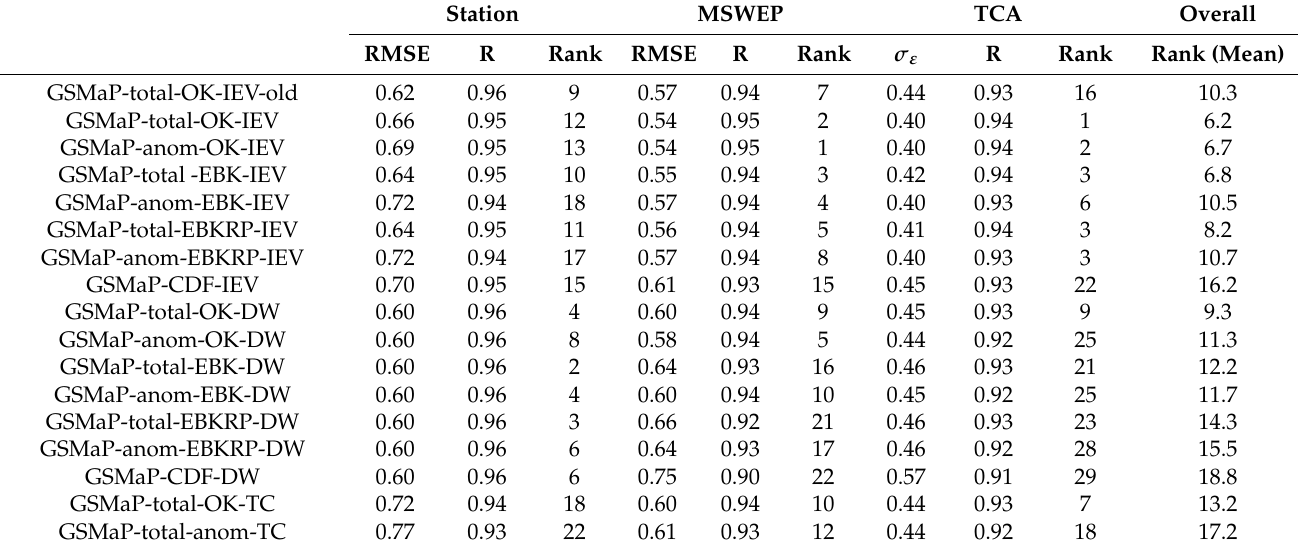
Table A3. Verification results for all corrected and blended datasets in this study.